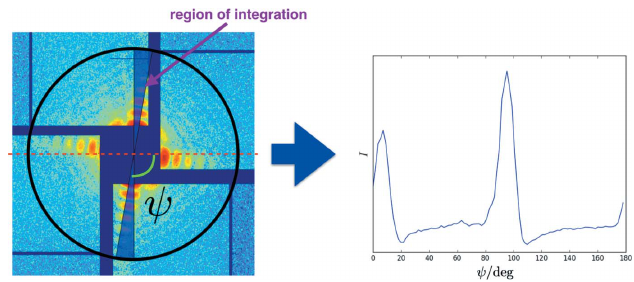
Figure 2 Angular profile conversion. The average intensity profile as a function of azimuth angle (right) is extracted from the raw pattern (left) (two sectors are plotted to show the region of integration at angle